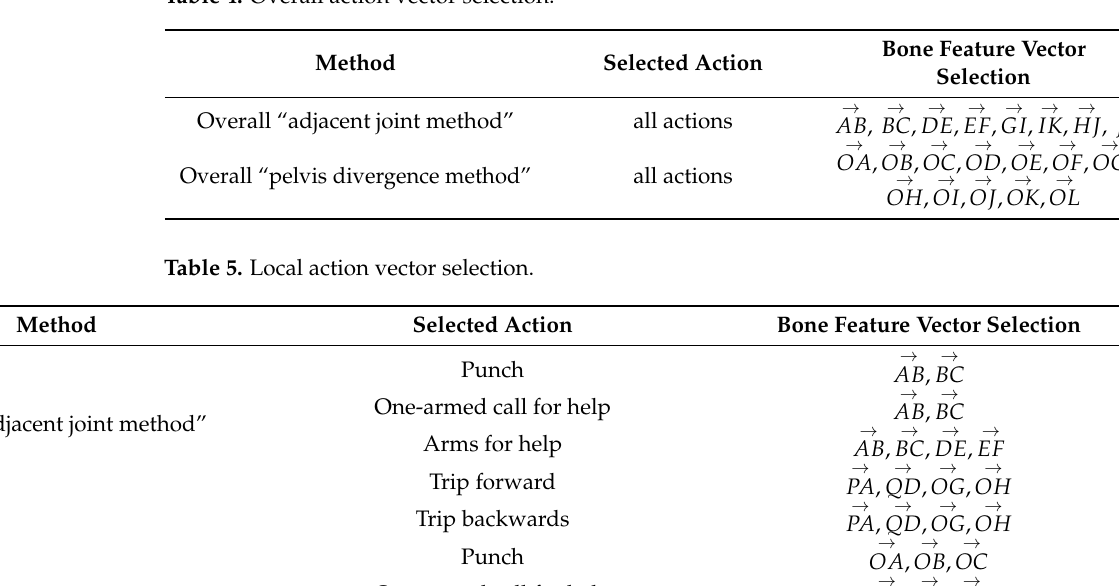
Table 4. Overall action vector selection.